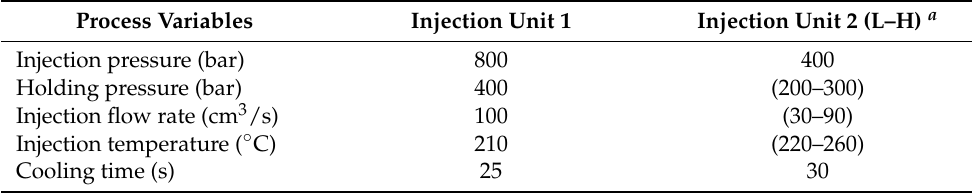
Table 1. Parameterized values of the injection molding process. Figure 2. Screw profile scheme used in the present experiment.